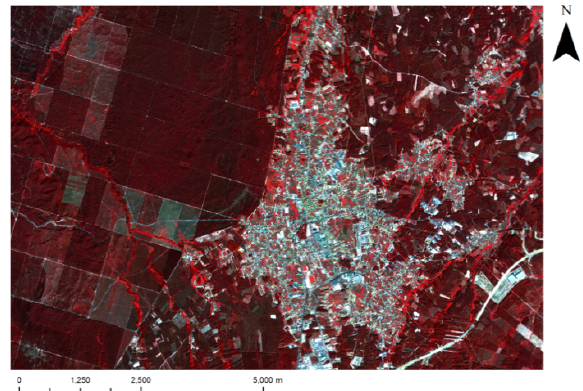
Figure 1. False color composition (432) of the multispectral IKONOS image